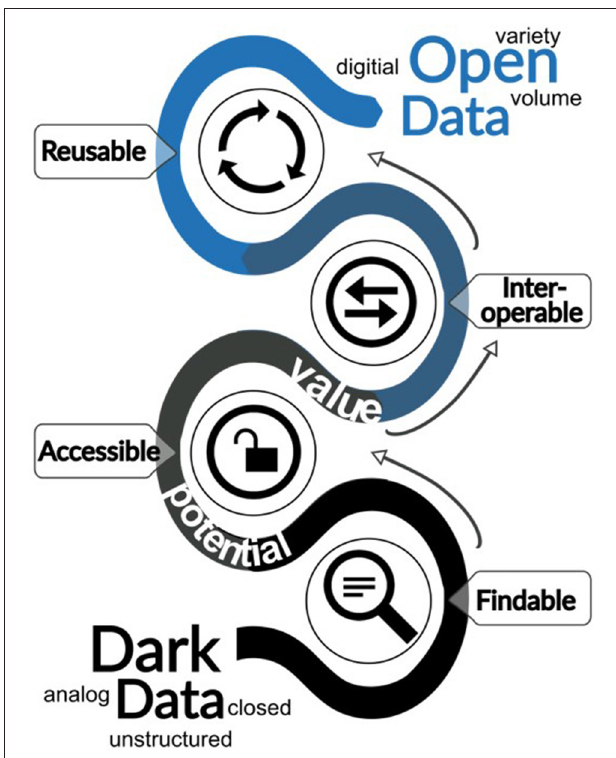
FIGURE 1 | Conceptual diagram of the FAIR roadmap for dark data: each curve represents a step toward increasing the value and potential of dark data for